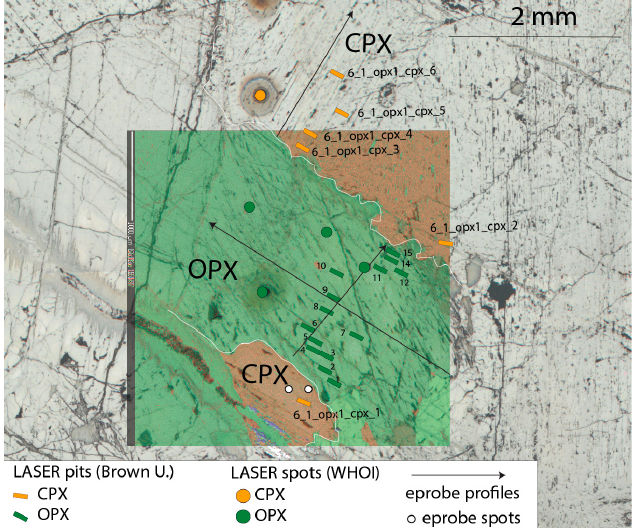
Figure 4. Example of combined LASER ablation inductively coupled plasma mass spectrometry (LA-ICP-MS) and electron probe microanalyses (EPMA) approach on adjacent pyroxene grains in LK12-6-1. One wavelength-dispersive spectroscopy (WDS) map (green area is OPX; red area is CPX) is superimposed to illustrate how grain boundaries and exsolutions were precisely mapped.